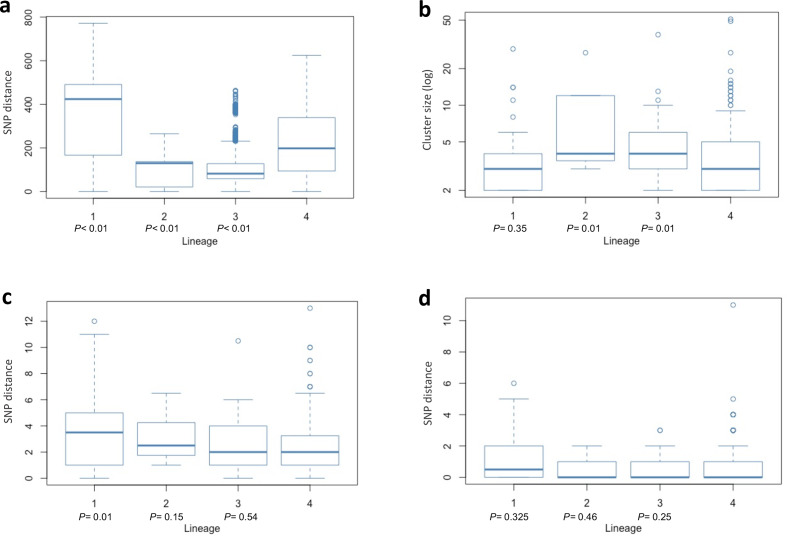
(a) Pairwise SNP distance by lineage between all Karonga strains used in the study. (b) Transmission cluster size by lineage, excluding non-clustered individuals. Clusters are defined as sampled strains (excluding non-sampled cases) linked either through direct transmission or with up to two transmission events inferred between individuals. P-values are a comparison against lineage 4 using the Wilcoxon rank sum test. (c) Median SNP distance in transmission clusters (sampled cases only). P-values are a comparison against lineage 4 using the Wilcoxon rank sum test. (d) Pairwise SNP distance between individuals in direct transmission events. P-values are a comparison against lineage 4 using the Wilcoxon rank sum test.